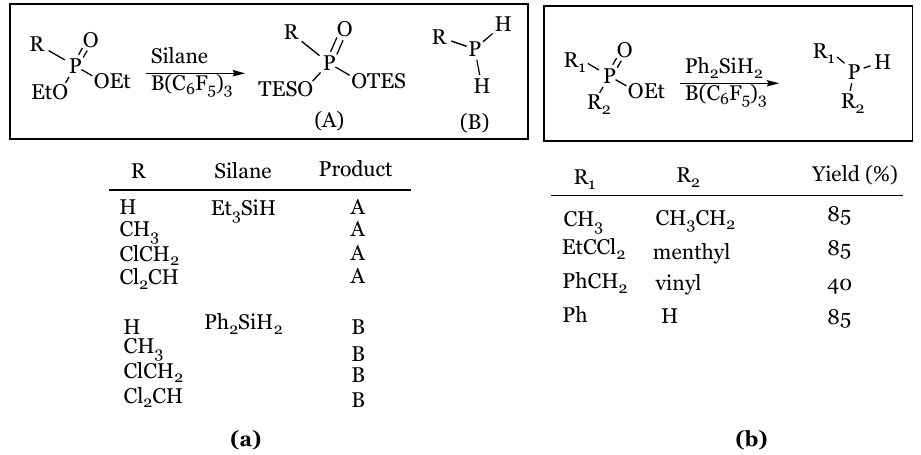
Figure 12. Reduction of phosphorous compounds: ( a ) Phosphonic esters; ( b ) Phosphinic esters.